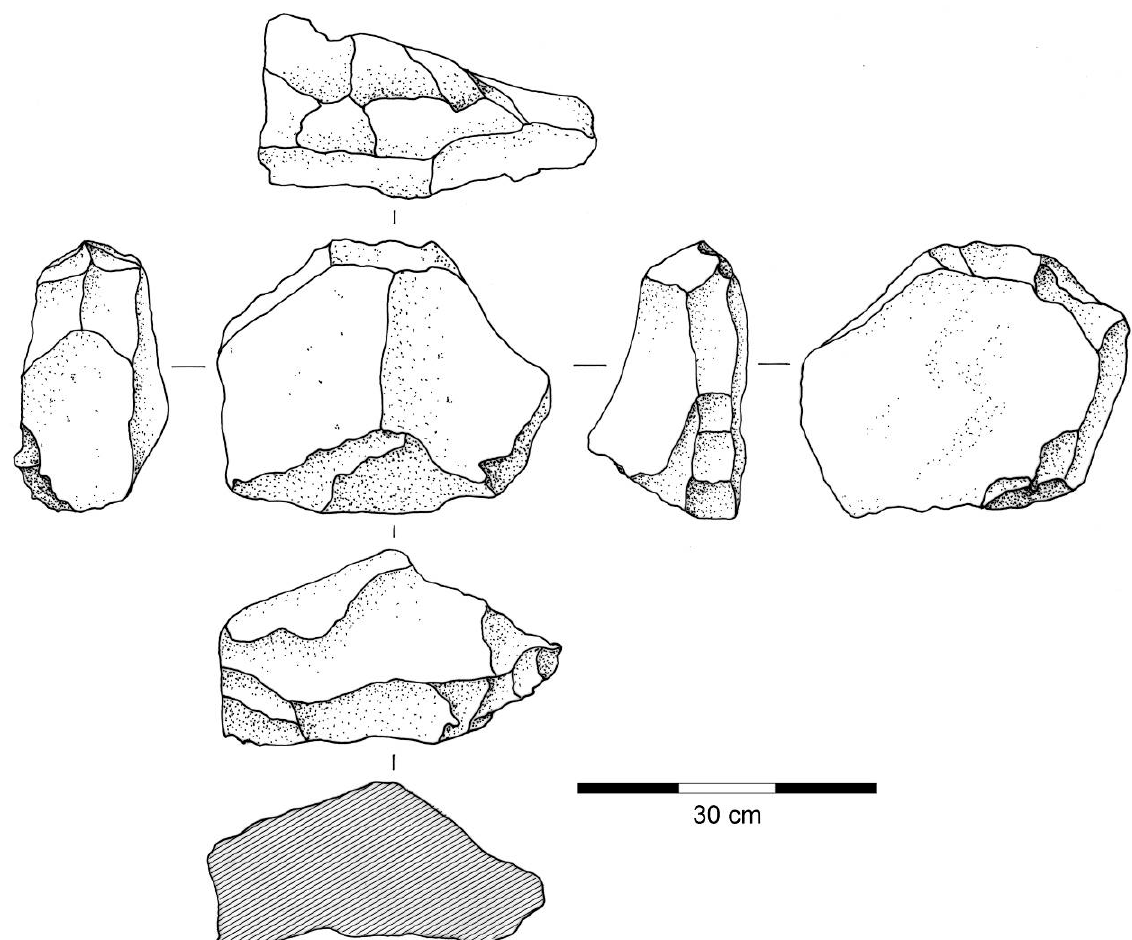
Figure 16. A flaked basalt boulder found by the entrance to Brush Hut 1, Floor